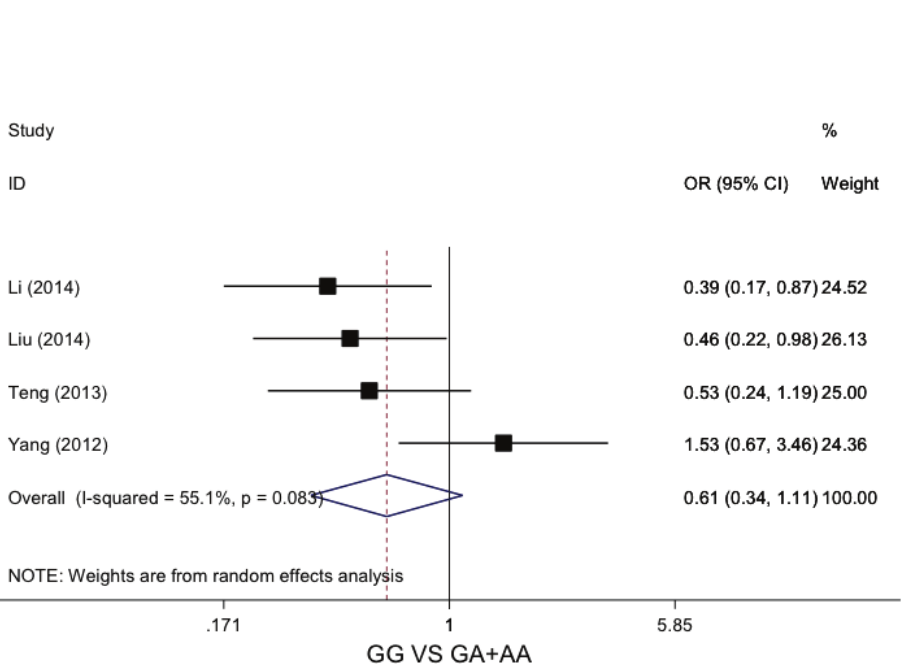
Figure 2: Forest plot of GSTP1 A>G polymorphisms and chemosensitivity of osteosarcoma in omozygous genetic model (GG vs